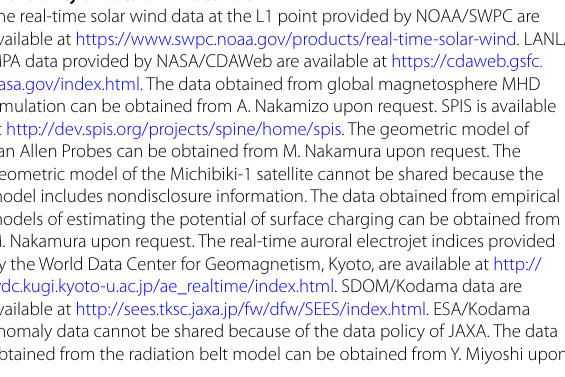
expanding the target region from GEO to medium and low Earth orbits.